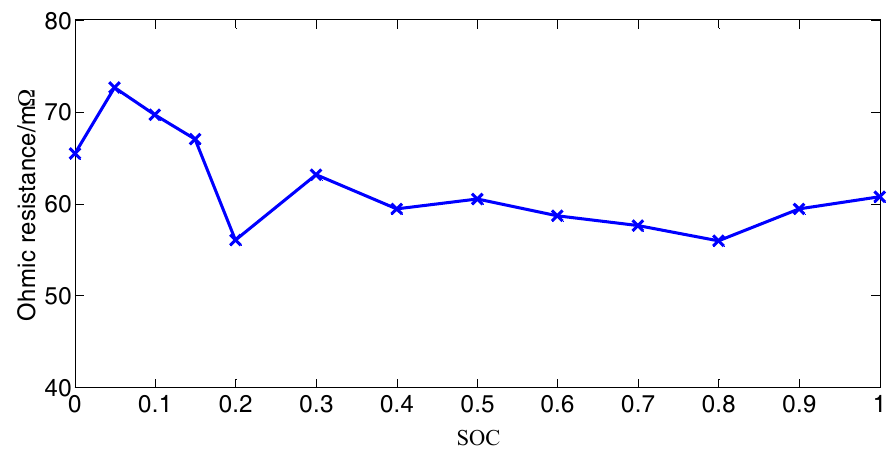
Figure 6. The varying curve of ohmic resistance with SOC.